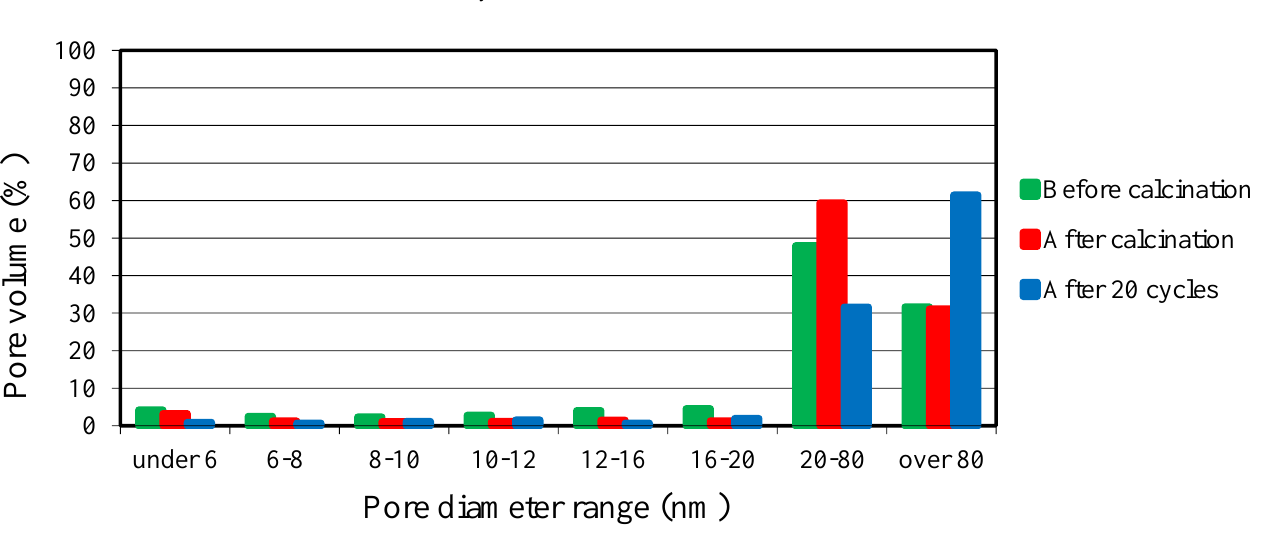
Figure 6. A comparison of Vitošov limestone pore size distribution before calcination, after calcination, and after 20 cycles.